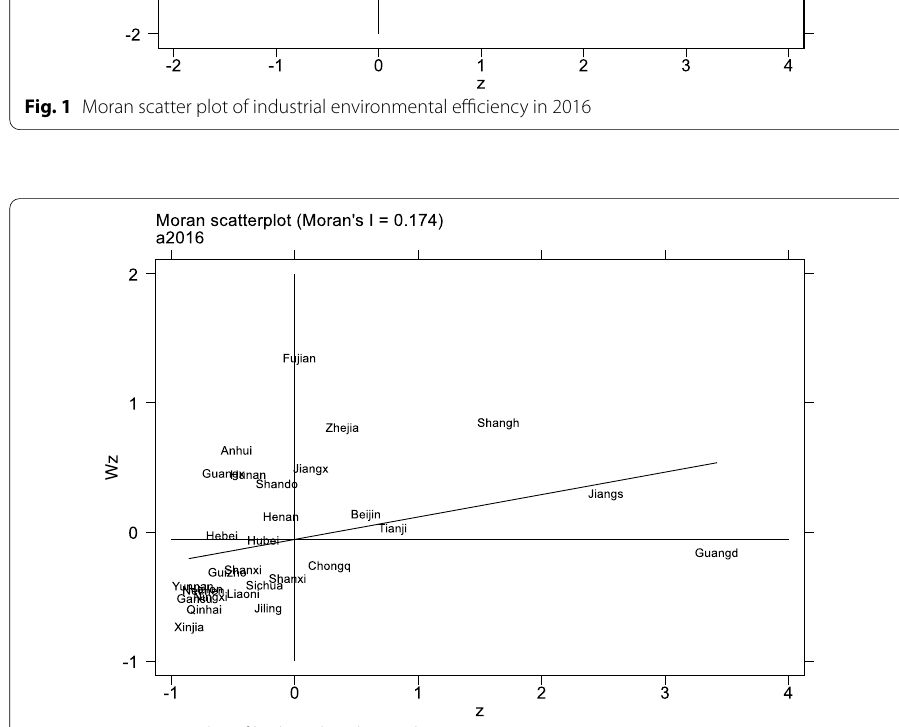
Fig. 2 Moran scatter plot of high-tech industry clusters in